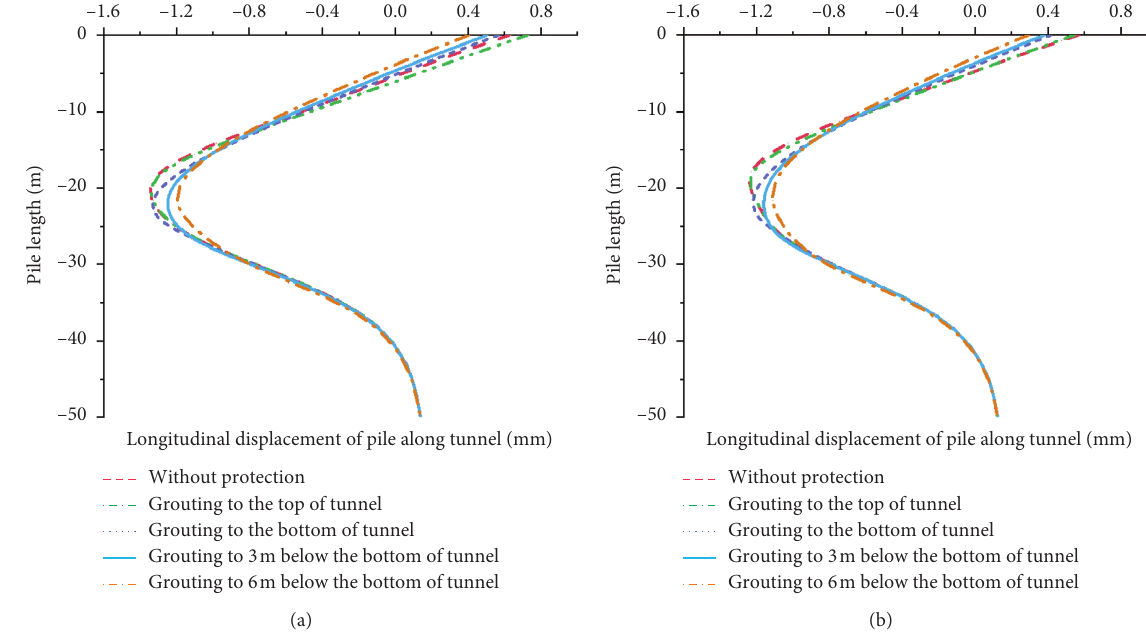
Figure 17: Longitudinal displacement of the pile along the tunnel: (a) 2 rings after passing the pile; (b) 4 rings after passing the